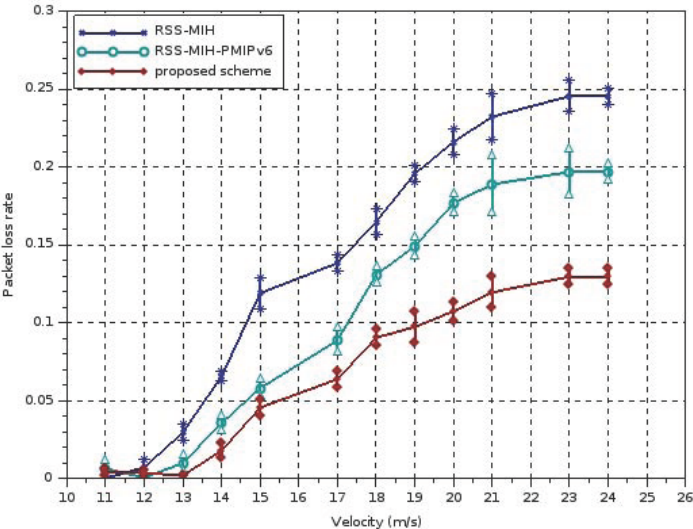
Figure 8. Packet loss rate according to velocity. The confidence interval is